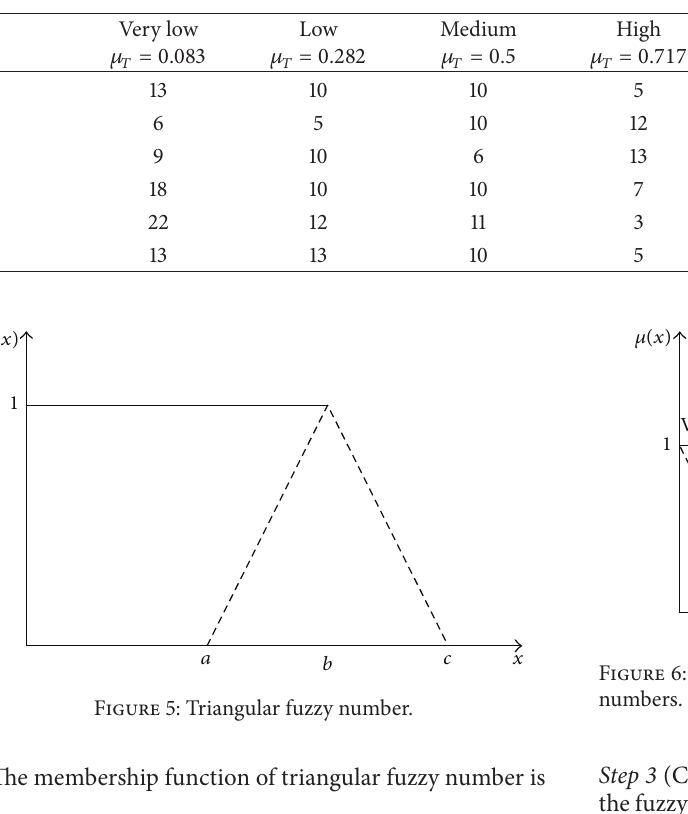
Table 7: Importance weights related to the six known criteria.